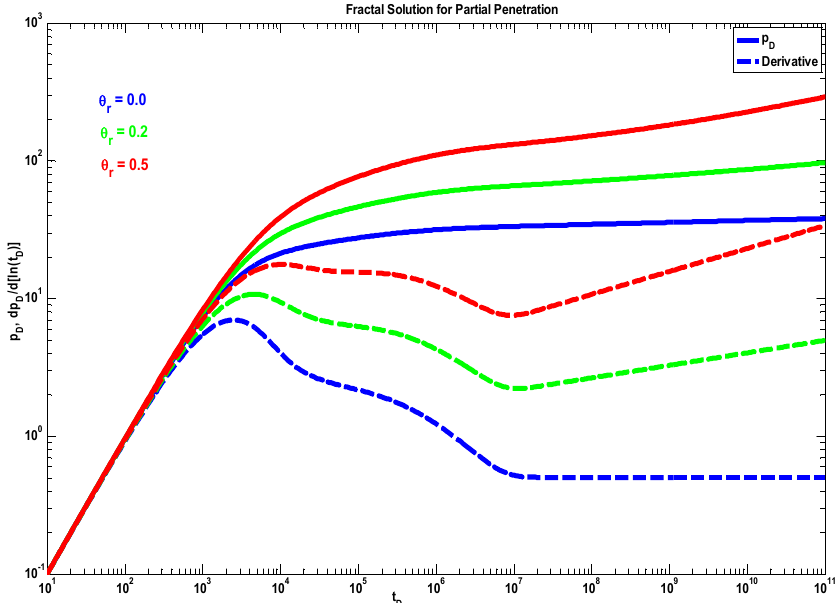
Figure 7. Fractal case: 𝑧 (cid:3050)(cid:3005) = 0.4 , ℎ (cid:3005) = 10000 , ℎ (cid:3043)(cid:3005) = 0.2 S = 0 , 𝐶 (cid:3005) = 100 , 𝜀 = 1 , 𝑑 (cid:3033)(cid:3045) = 2 , 𝑑 (cid:3033)(cid:3053) = 1 , 𝜃 (cid:3053) = 0.